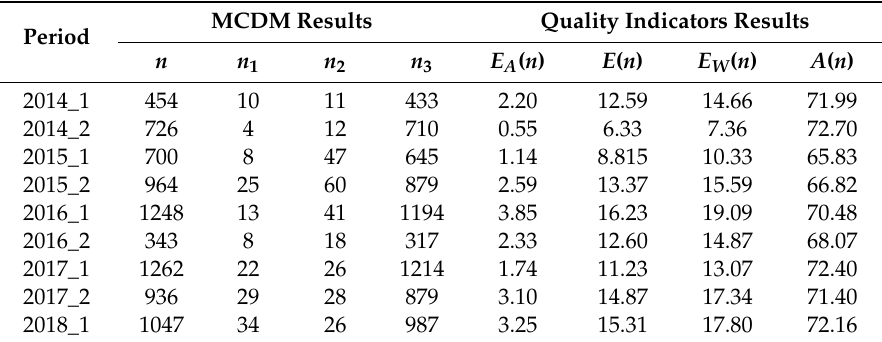
Table 5. Comparison between adequacy and excellence